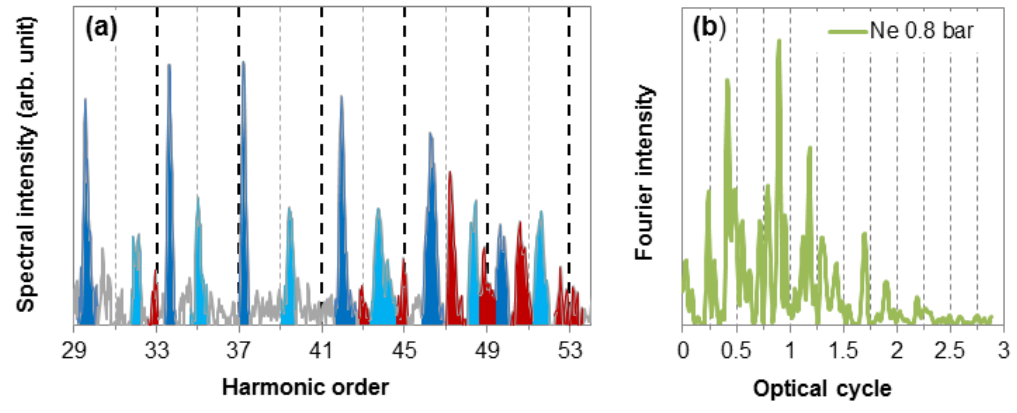
Figure 10. ( a ) Using 400 fs-long laser pulses with a peak intensity of ~1 × 10 15 W/cm², we observed harmonic lines from neon explained by multiply re-scattered electrons. The harmonics orders (4i + 1) and (4i + 3) are marked by thick and thin black dashed lines, respectively. ( b ) Fourier transform of the measured